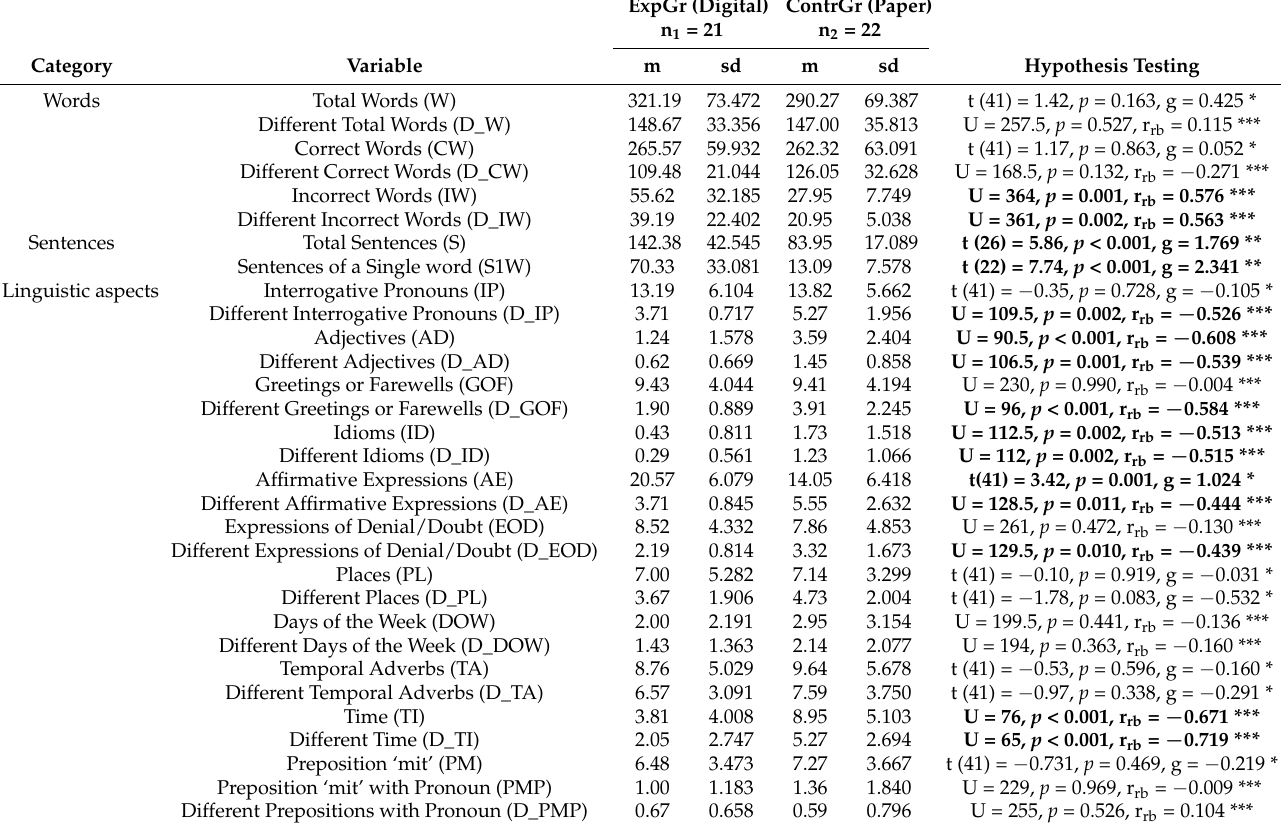
Table 1. Descriptive statistics and hypothesis testing results in order to answer